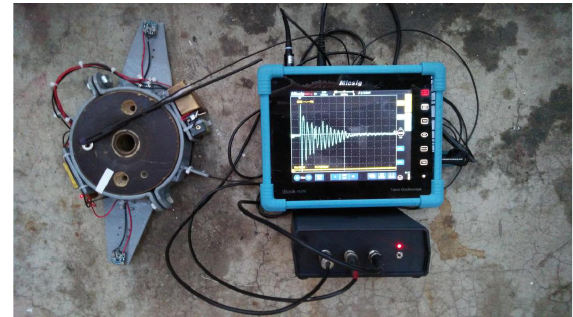
Fig. 2. View of the measuring unit